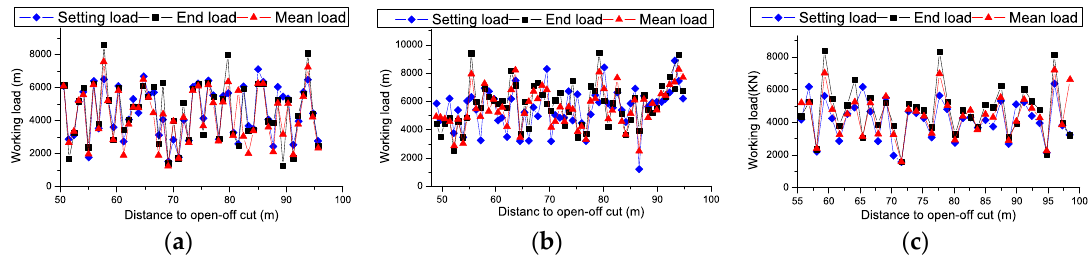
Figure 7. Relationship between the work load and the proceeding distance of the open-off cut at ( a ) support 7, ( b ) support 50, and ( c ) support 102.